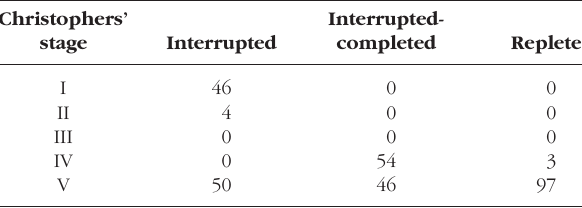
Table II. – Second experiment: percentage of females in each Chris- tophers’ stage 77 h after a blood